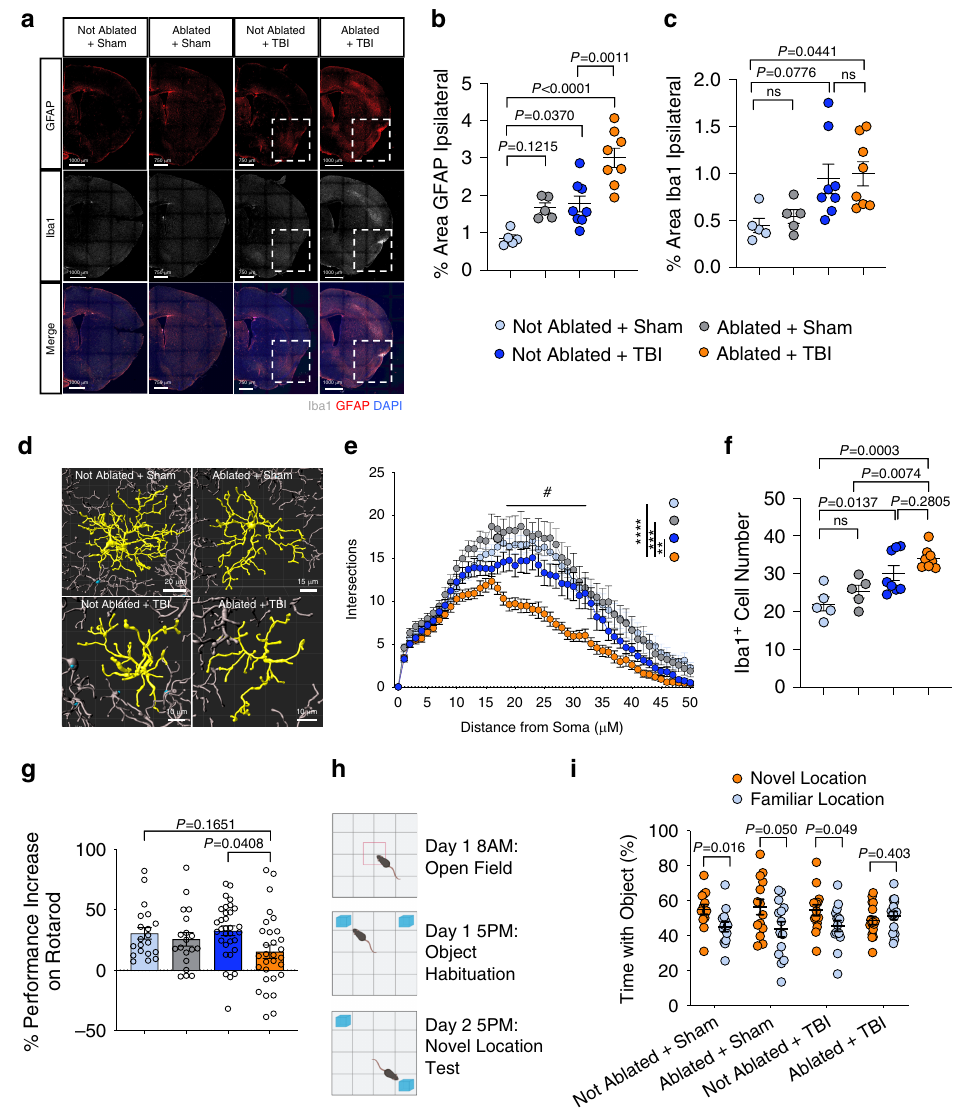
Fig. 6 Prior lymphatic defects lead to exacerbated TBI-induced in fl ammation and cognitive decline. Mice were subjected to meningeal lymphatic photoablation or a control procedure and then to TBI or a sham procedure 1 week later. a – f Brains were harvested 2 weeks after TBI. a Representative images of the brain hemisphere ipsilateral to the injury and quanti fi cation of the percent area of ( b ) GFAP (red) and ( c ) Iba1 (gray) immunoreactivity (Sham groups n = 5, TBI groups n = 8). Dashed boxes denote the injury site. d Representative reconstructions of morphology of Iba1 + cells and ( e ) Sholl analysis. Each data point represents the number of Iba1 + branches intersecting with a radius of 0 – 50 μ m from the soma, calculated by the average of 20 microglia per group (4 Iba1 + cells per section, 5 mice per group). Number sign (#) indicates that all control groups were signi fi cantly different from the Ablated + TBI group from 18 – 32 μ m; **** P < 0.0001, *** P = 0.0003, ** P = 0.0034 (calculated at 23 μ m). f Quanti fi cation of the average number of Iba1 + cells per fi eld of view (Sham groups n = 5, TBI groups n = 8). g The percent performance increase on the accelerating rotarod from day 1 to day 3 post TBI or sham procedure (Not Ablated + Sham n = 20, Not Ablated + TBI n = 32, Ablated + Sham n = 19, Ablated + TBI n = 30; pooled data from four independent experiments). h NLRT experimental schematic and i percent time the mouse spent investigating each object over the total time investigating both objects (Not Ablated + Sham n = 14, Not Ablated + TBI n = 15, Ablated + Sham n = 14, Ablated + TBI n = 16; pooled data from two independent experiments). Each point represents the percent time one mouse spent with either the novel location object (orange) or the familiar location object (blue). All other n values refer to the number of mice used and the error bars depict mean ± s.e.m. P values calculated by two-way ANOVA with Tukey ’ s multiple comparison correction ( b , c , e , f , g ) and mixed two-tailed unpaired Student ’ s t-test with Holm-Sidak multiple comparison correction ( i ). Source data ( b – c , e – g , i ) are provided as a Source data fi